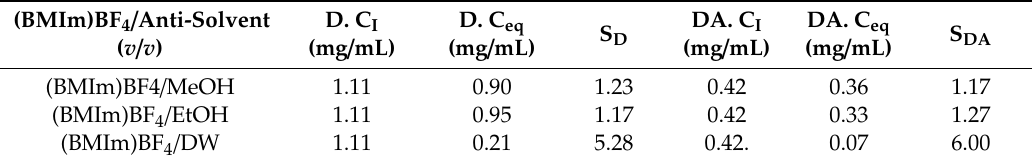
Table 5. Supersaturation levels of D and DA in various A. gigas –IL extraction solution / anti-solvents (1:5 ( v / v